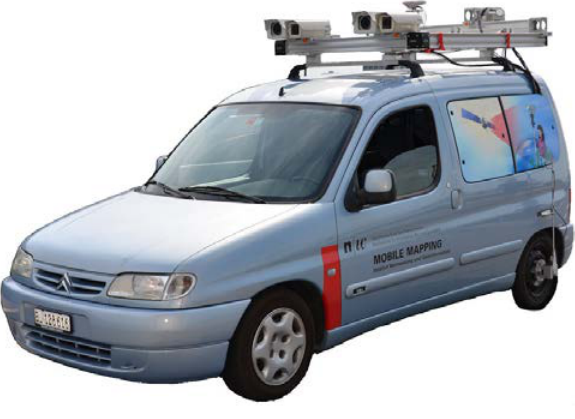
Figure 1. System overview with experimental camera setup Depending on the mapping mission the camera sensors are operated with 5 to 30 frames per second. The sensors are mounted on a rigid platform, ensuring that the relative orientation between them remains constant during the mission.